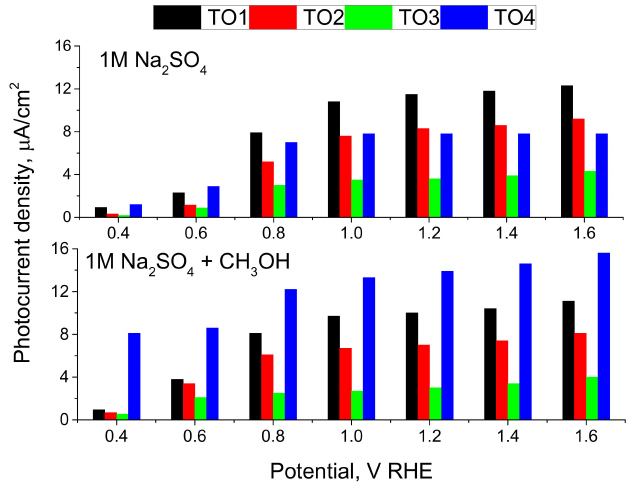
Figure 8. Photocurrent density dependence on potential without (upper plots) and with methanol (bottom